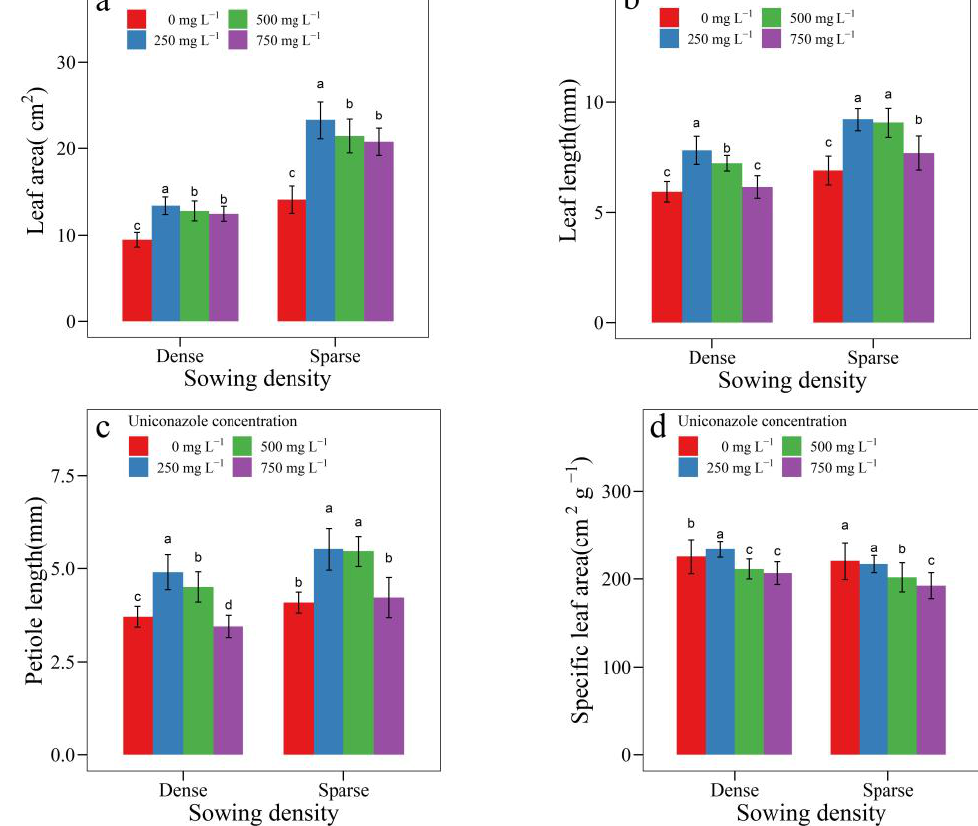
Figure 2. The effect of uniconazole on leaf traits in two sowing densities. Values are the leaf traits measured at 30 d of leaf area ( a ), leaf length ( b ), petiole length ( c ), and specific leaf area ( d ). Sparse and dense represent sowing densities of 400 and 800 seeds per tray, respectively. Significant effects ( p ≤ 0.05) are shown by different letters in the same sowing density.